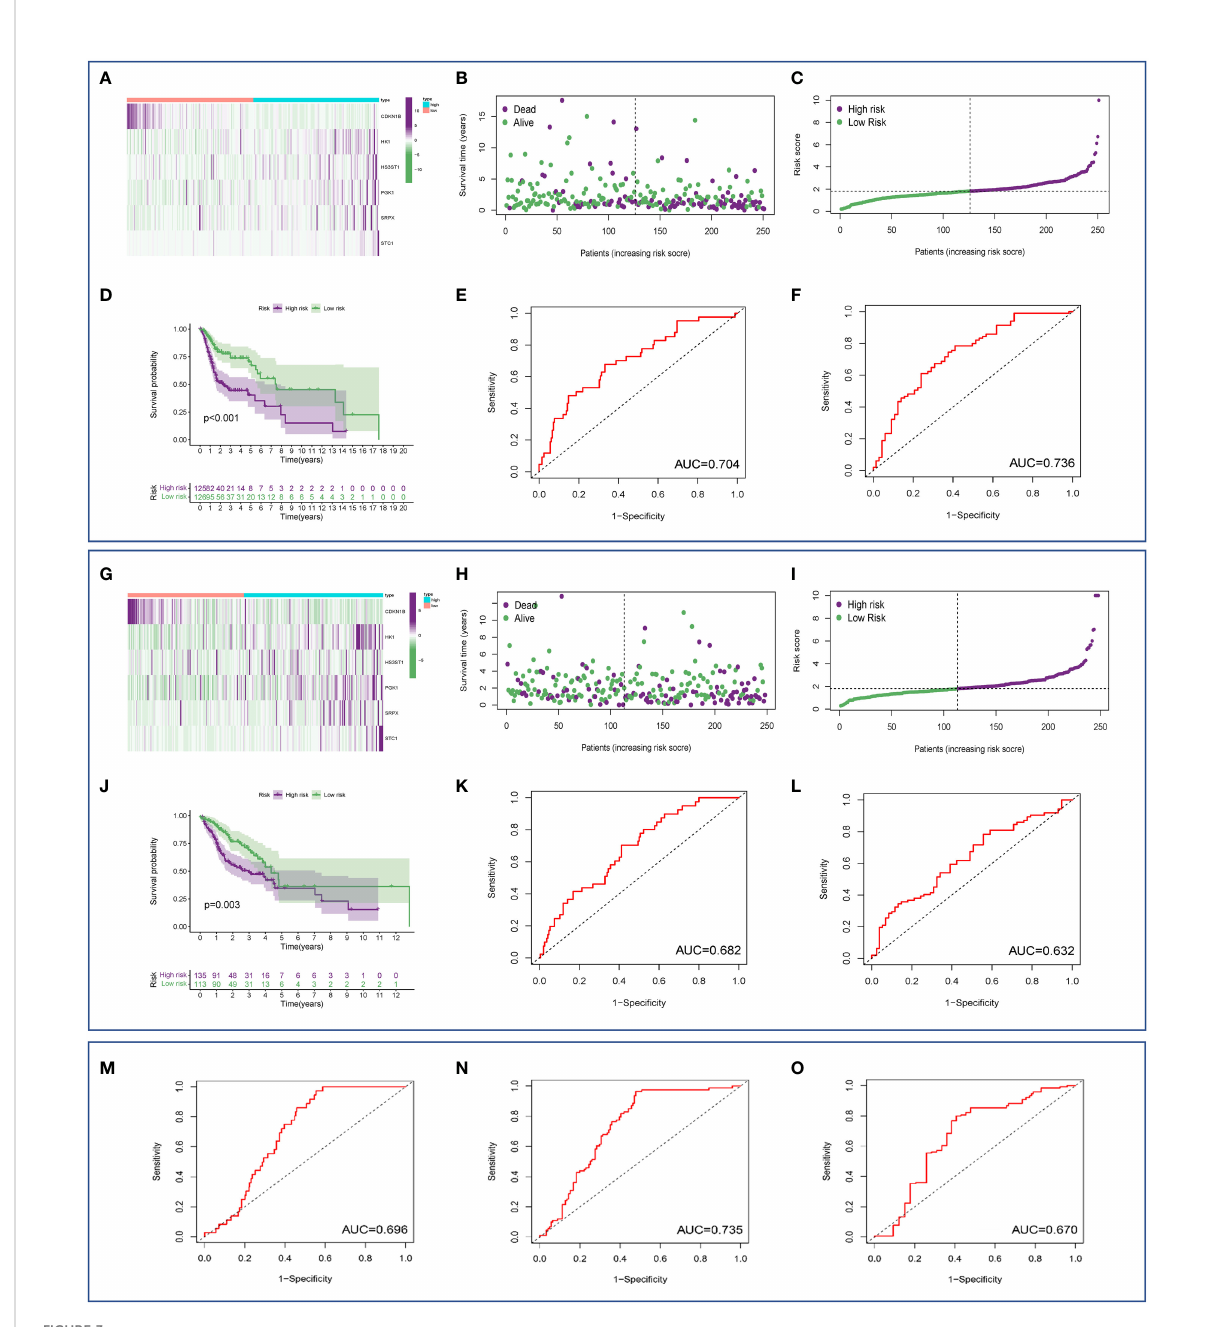
FIGURE 3 Estimation of the prognostic model based on HRGs. (A) Heatmap of 6 HRGs in the training set. (B) Scatterplot of patient survival in the training cohort. (C) Survival rate was signi fi cantly associated with risk score in the training cohort. (D) Kaplan-Meier survival curves of the high- and low- risk groups in the training cohort. (E, F) ROC curves based on the risk score model in the training cohort. (G) Heatmap of 6 HRGs in the validation cohort. (H) Scatterplot of patient survival in the validation cohort. (I) Survival rate was signi fi cantly associated with risk score in the validation cohort. (J) Kaplan-Meier survival curves of the high-risk group and the low-risk group in the validation cohort. (K, L) ROC curve based on the risk score model in the validation cohort. (M – O) External validation (GEO database) of an HRG-based prognostic